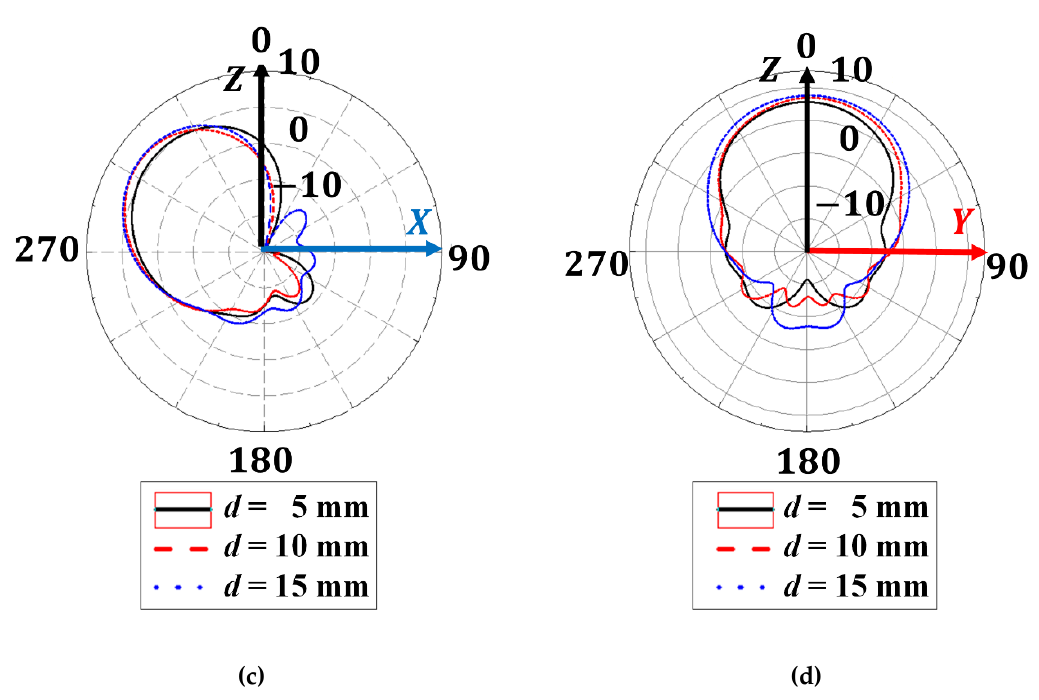
Figure 6. Simulated reflection coefficients for ( a ) proposed antenna and ( b ) reference antenna 1 (Ref. Ant. 1) with respect to antenna and MM separation (d); simulated two-dimensional radiation patterns at 2.65 GHz on ( c ) XZ and ( d ) YZ planes for different d.